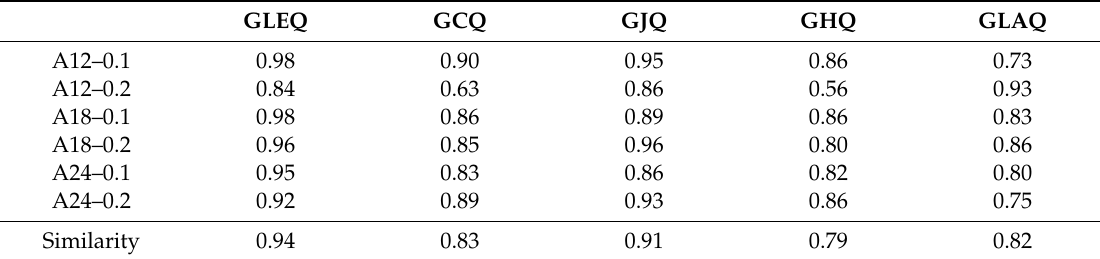
Table 6. Calculated correlation coe ffi cient results between FE simulation and analytical solution by five di ff erent numerical methods; the Gauss–Legendre quadrature method (GLEQ) shows the highest similarity. GCQ: the Gauss–Chebyshev quadrature; GJQ: the Gauss–Jacobi quadrature; GHQ: the Gauss–Hermite quadrature; GLAQ: the Gauss–Laguerre